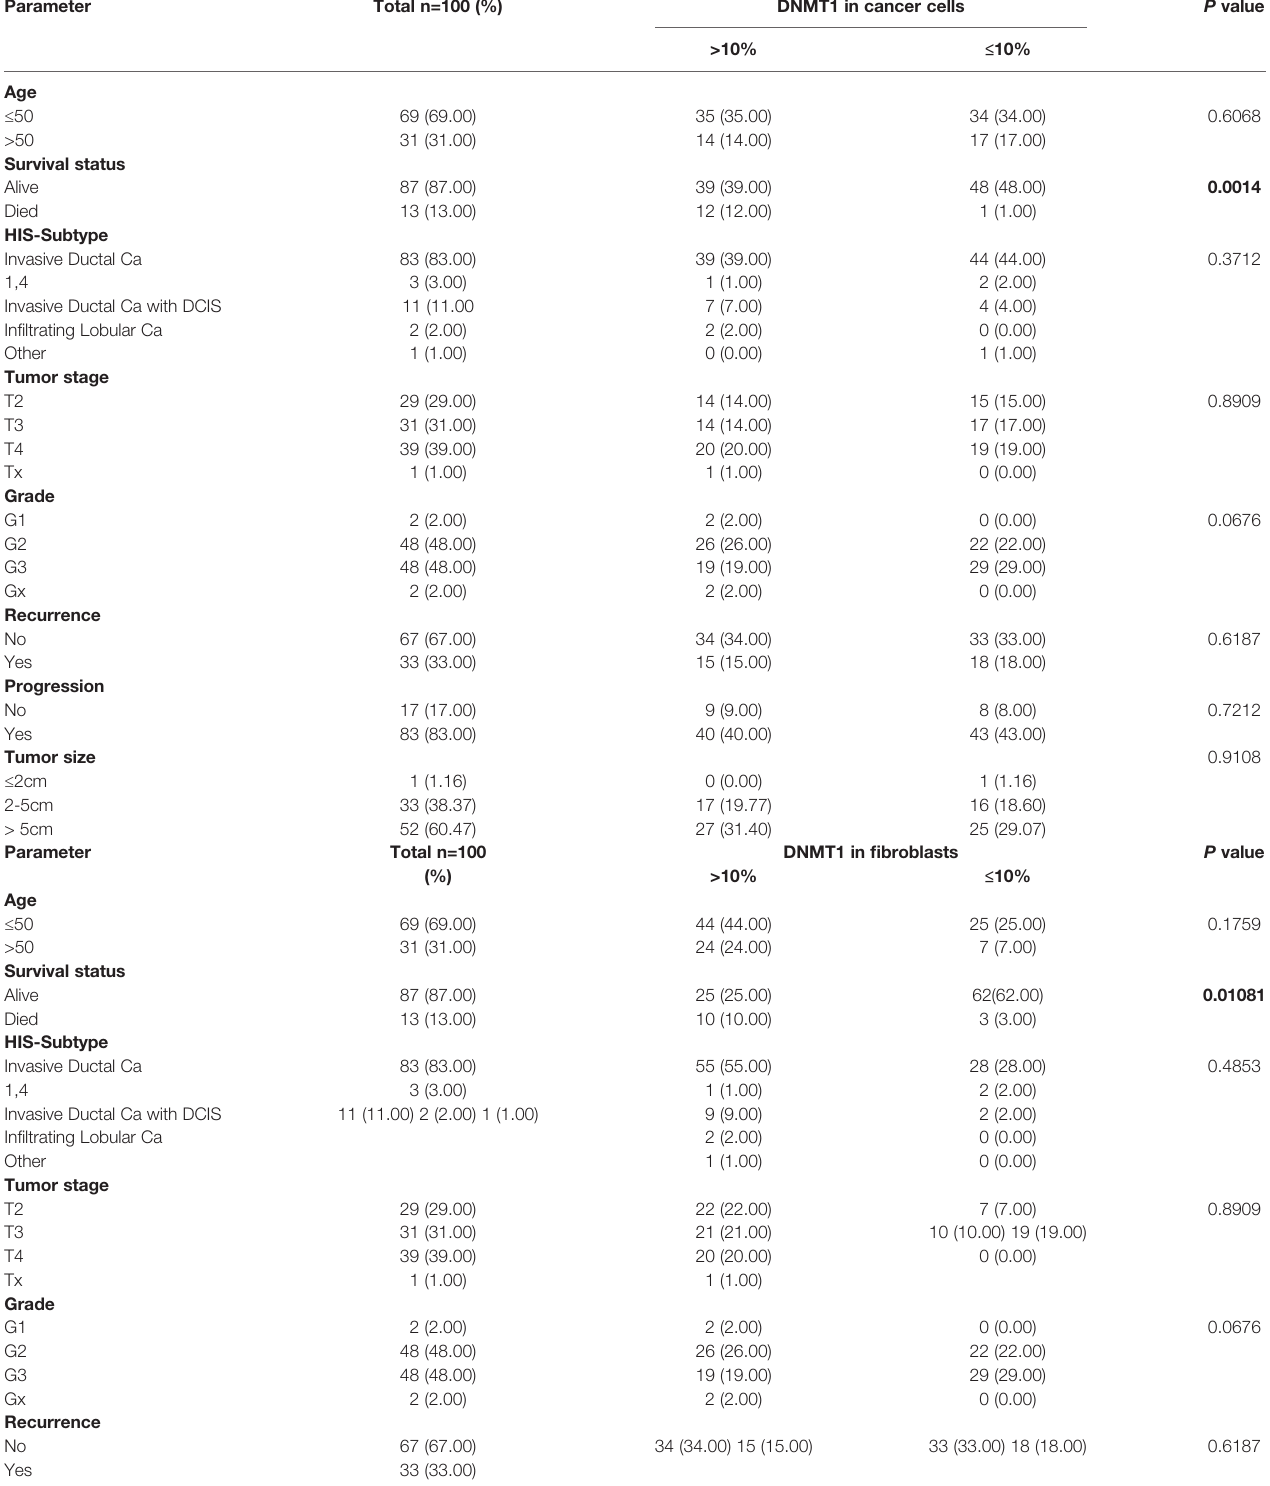
TABLE 1 | Correlations between DNMT1 expression and clinicopathological features in breast cancer